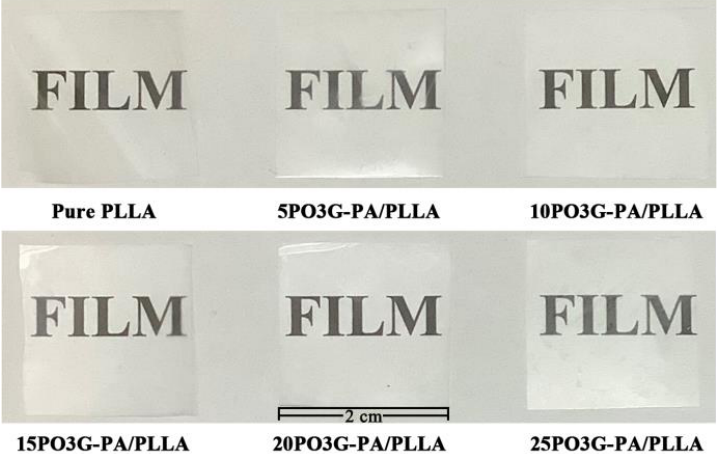
Figure 9. Surface morphology of PO3G–PA/PLLA composite films with different ratios.